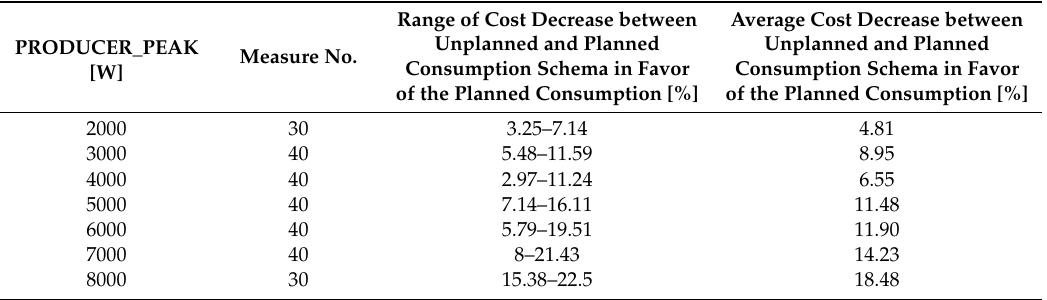
Table 4. ResultsfromasetofprofilesgeneratedbythesimulatorforPRODUCER_COST = 0.3RON / Table 4. Results from a set of profiles generated by the simulator for PRODUCER_COST = 0.3 RON/1000W.